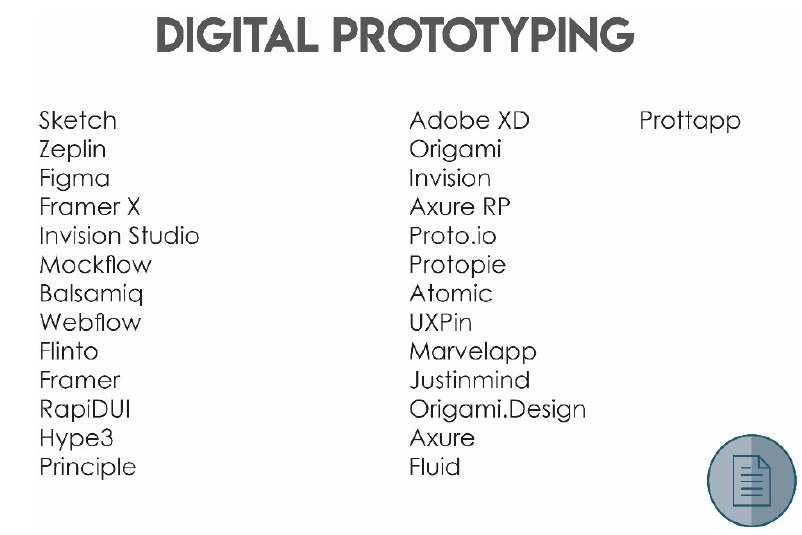
Figure 7. Example of a reference card.